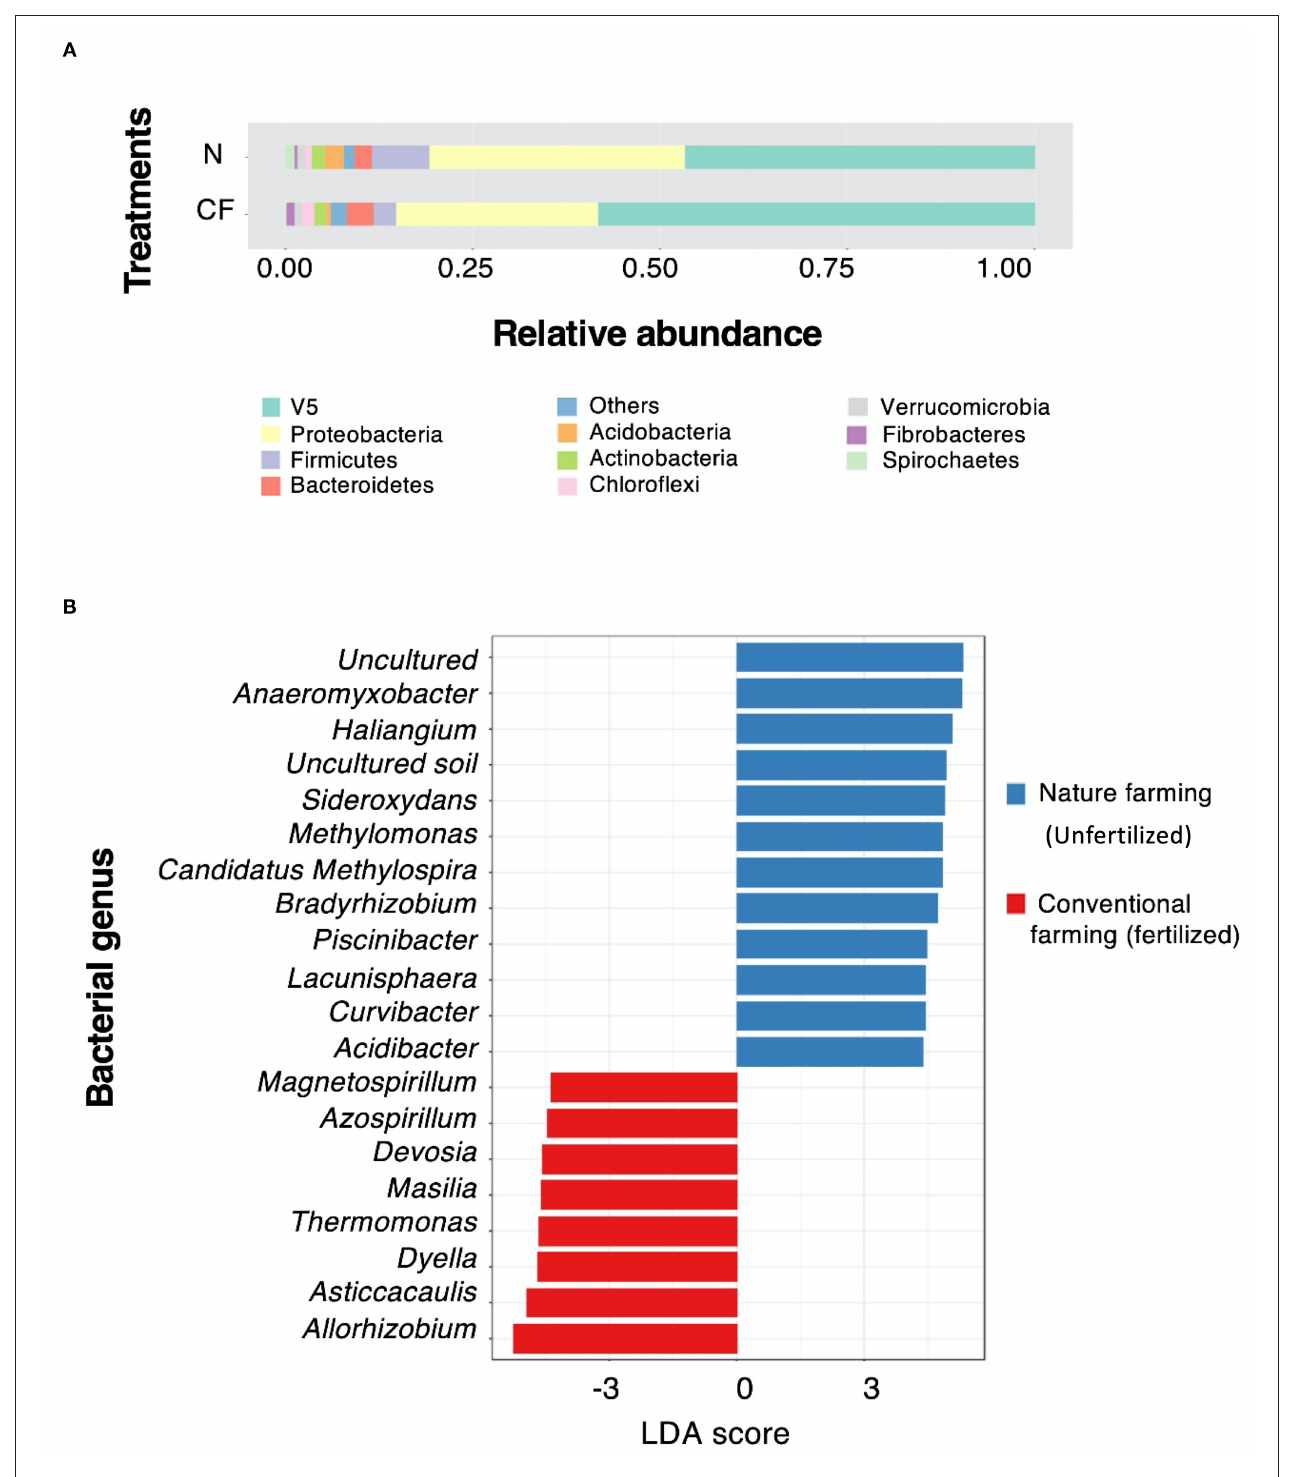
FIGURE 4 | Root microbial community composition between unfertilized nature farming and fertilized conventional farming. (A) Relative abundance of dominant phyla under unfertilized nature farming (N) and fertilized conventional farming (CF) conditions. (B) Linear discriminate analysis (LDA) of the effect size (LEfSe) of the preferential taxa at the genus level under unfertilized nature farming and fertilized nature farming conditions. Only taxa with LDA > 0.4 are shown. V5 refer to taxonomy labels which not assigned or other category cannot be projected to lower taxonomy.